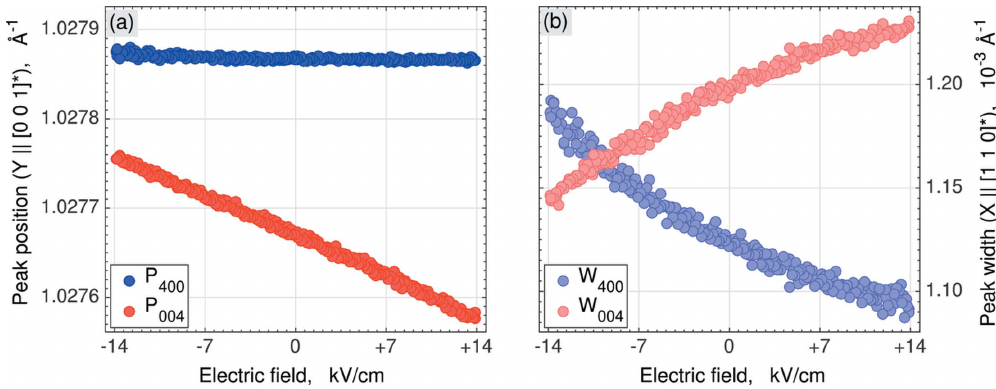
Figure 4 Best-fit values of the ‘position’ and ‘width’ parameters of the 004 (red) and 400 (blue) reflections as a function of time and applied electric field. ( a ) The Y component of the Bragg-peak positions P 004 and P 400 . ( b ) The X component of the Bragg-peak widths W 004 and W 400 .